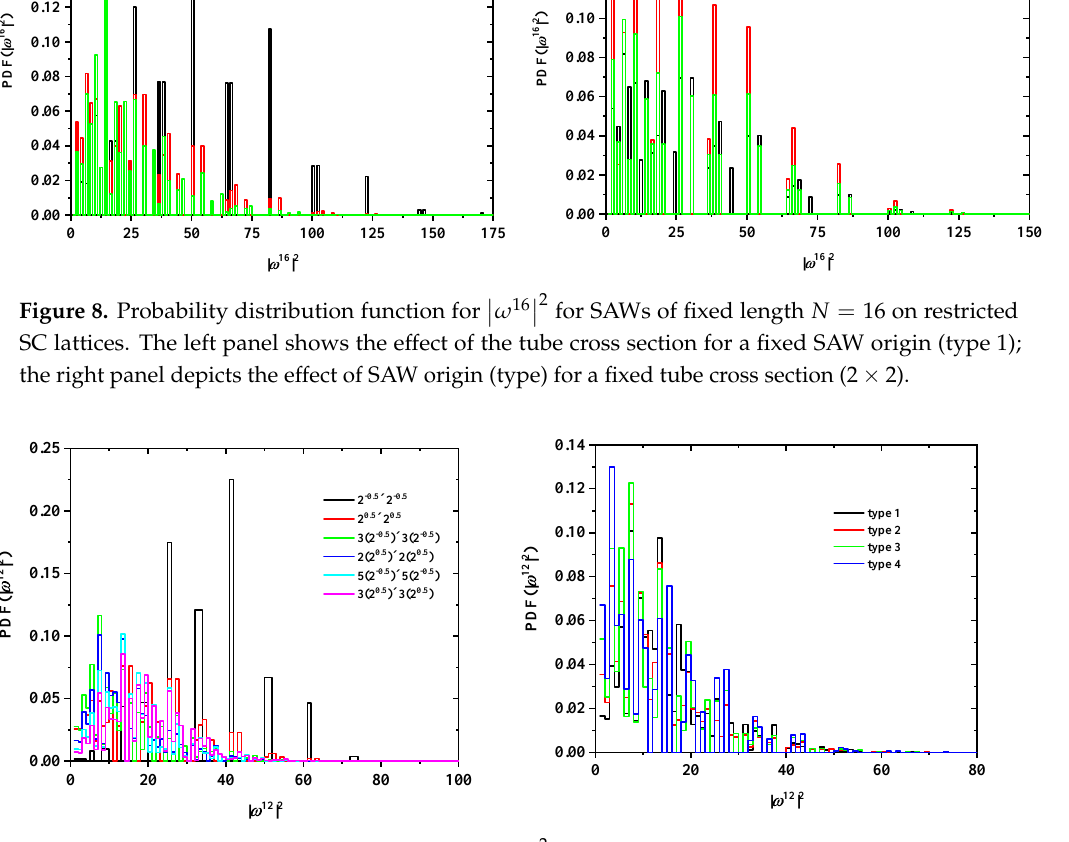
Figure 9. Probability distribution function for FCC lattices. The left panel shows the effect of tube cross section for a fixed SAW origin (type 1); the right panel depicts the effect of SAW origin (type) for a fixed tube cross section (2